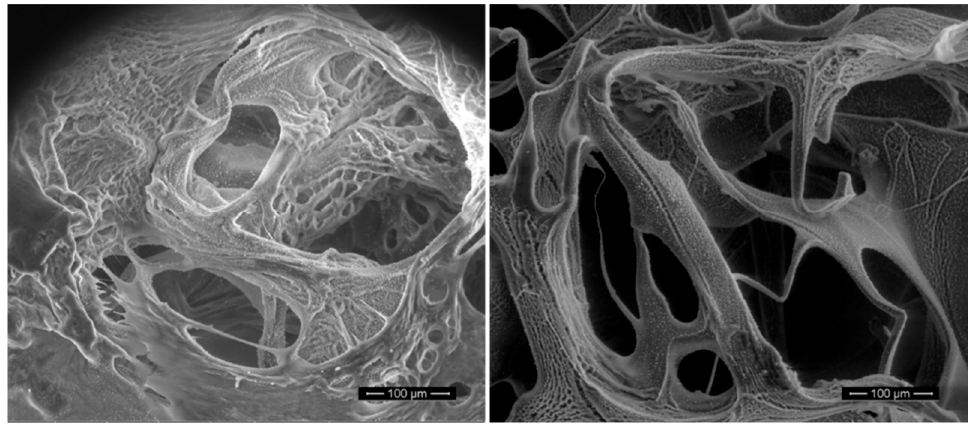
Figure 5. Cross-section SEM images of freeze-dried injectable hyaluronic acid hydrogels.